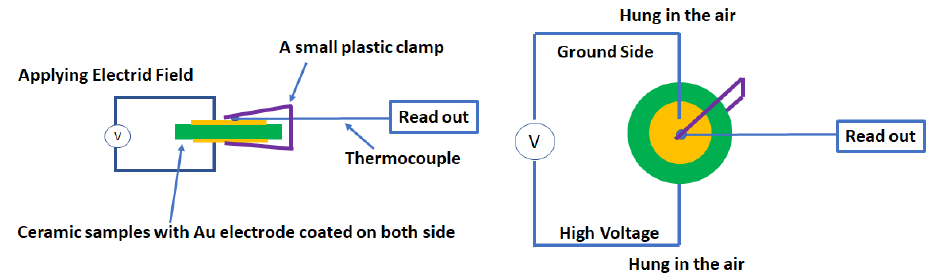
Figure 1. Schematic diagram of the electrocaloric effect measurement setup.